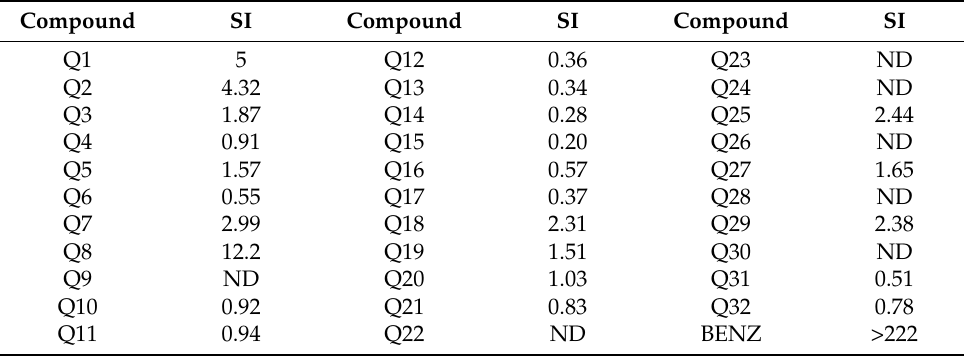
Table 3. Selectivity index (SI) of the acrylonitriles. ND: not determined.